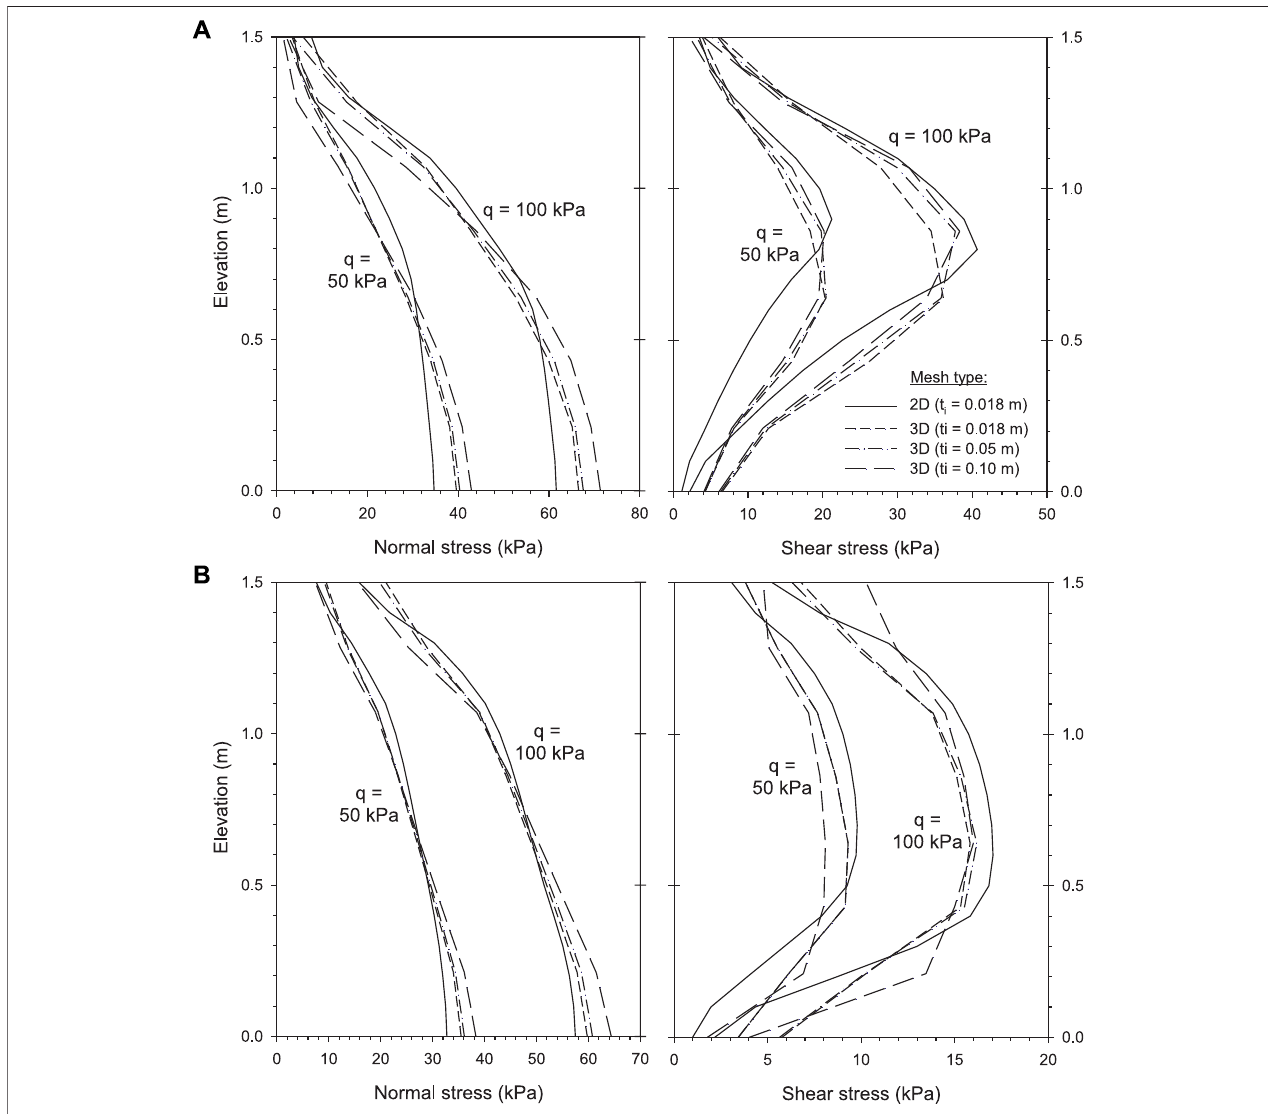
FIGURE 19 | Load transfer from back fi ll soil to facing panel: normal and shear stresses using different interface thickness (ti = 0.018, 0.05, and 0.10 m): Cross- section at x = 0.509 m. Cases with (A) Ri = 0.8 and (B) Ri = 0.3.